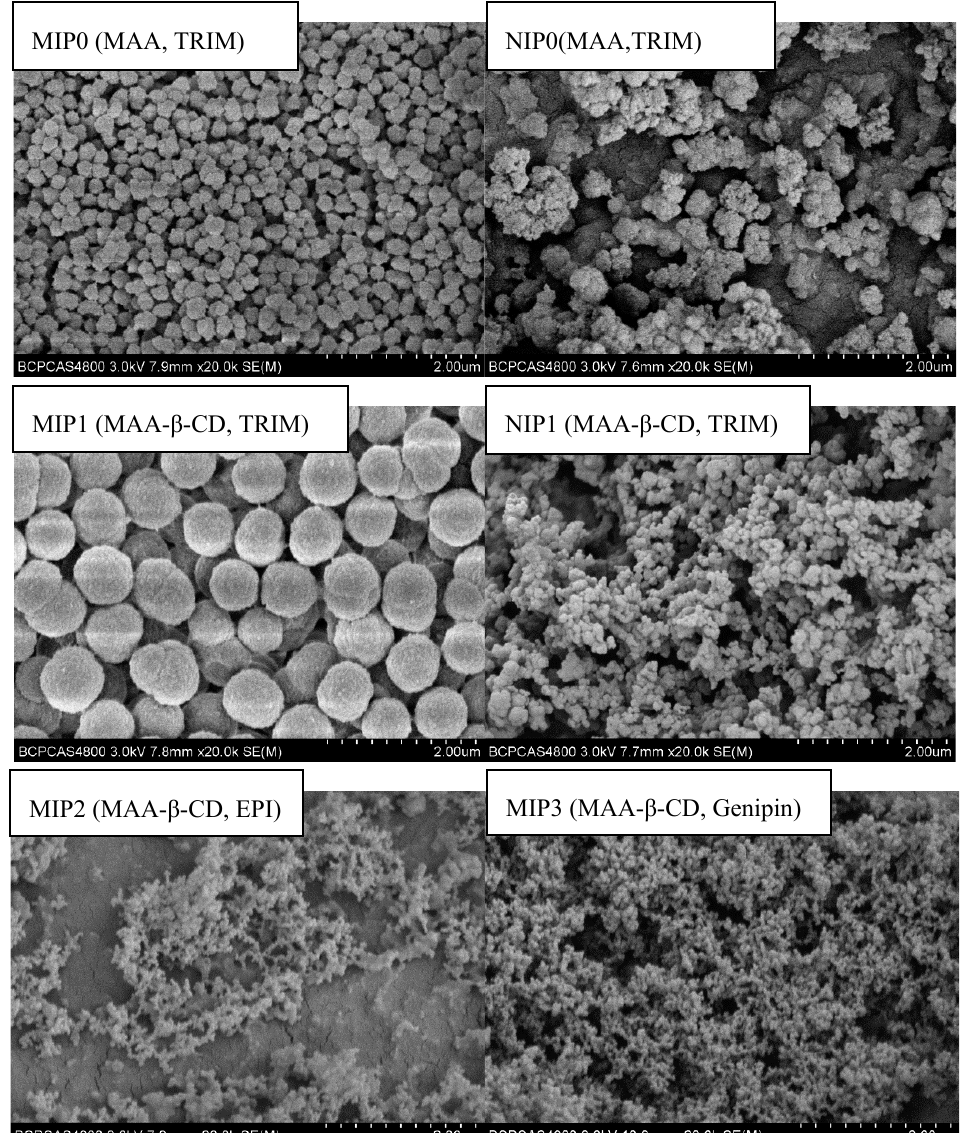
Figure 3. Scanning electron micrographs of different microspheres.